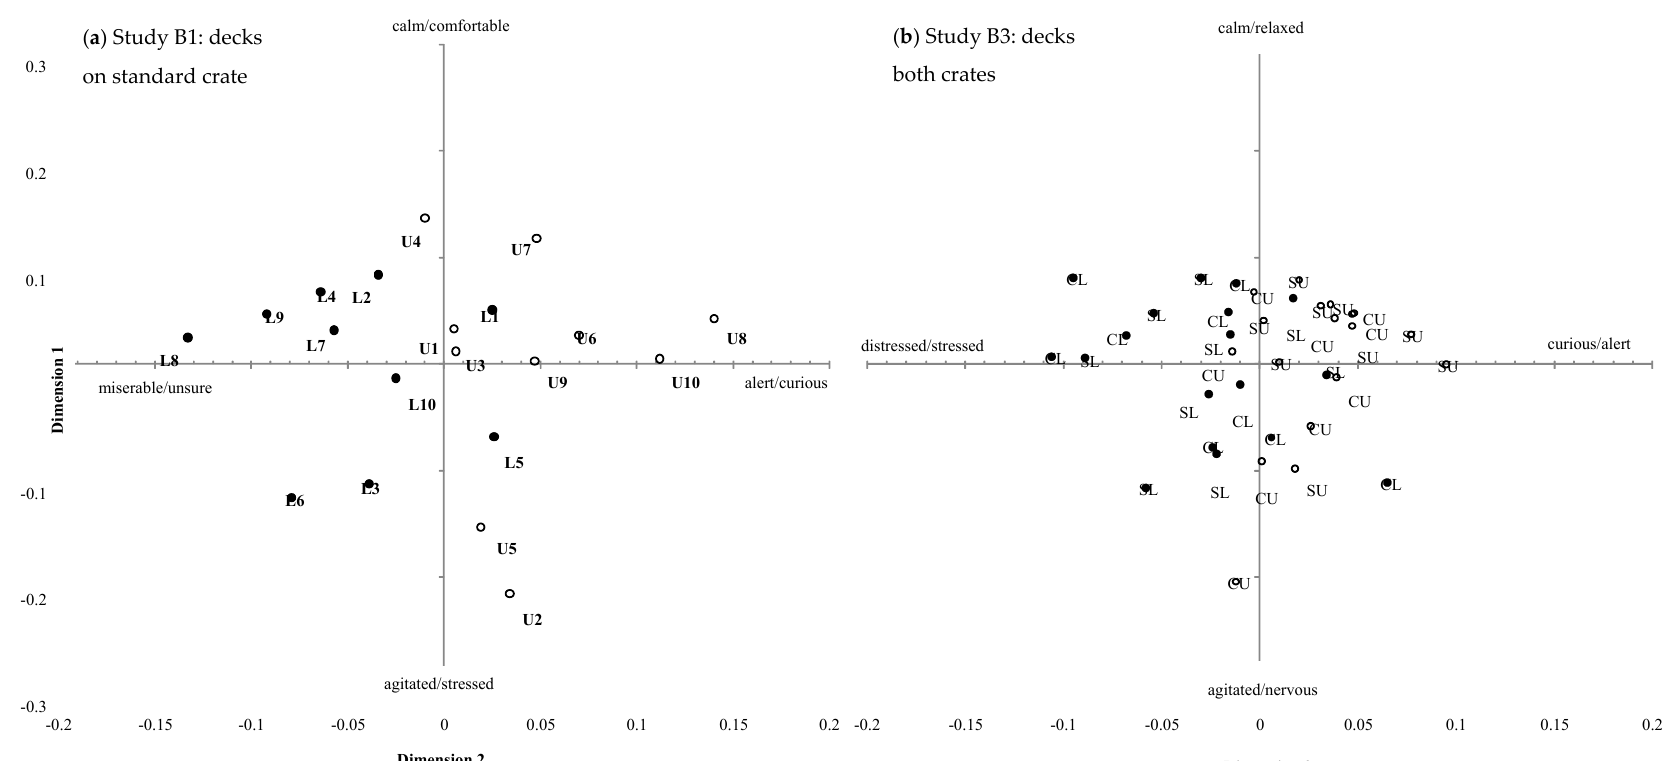
Figure 6. Positions of individual transport clips on GPA dimensions 1 and 2 obtained for ( a ) Study B1 standard crate experiment (Numbers represent each transport trip, U: upper deck, open circles, or L: lower deck, closed circles) and ( b ) Study B3 crate design experiment (SU: standard crate upper deck, open circles, SL: standard crate lower deck, closed circles, CU: convertible crate upper deck, open circles and CL: convertible crate lower deck, closed circles). Bold text indicates GPA dimensions 2 for both studies were statistically significantly different between treatments.